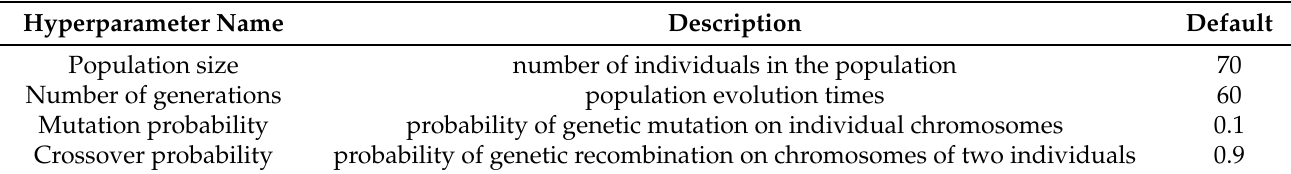
Table 4. Hyperparameters related to genetic algorithm in GA-BP neural network